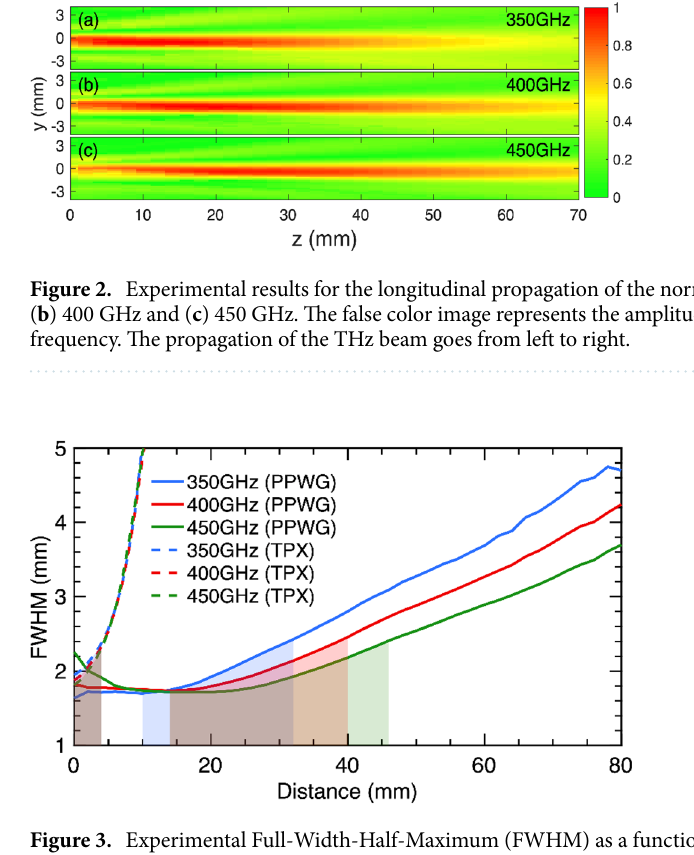
Figure 3. Experimental Full-Width-Half-Maximum (FWHM) as a function of distance and frequency for the TPX lens and the metallic axicon. The shaded regions denote the depth of focus of the two optical elements. These shaded regions star at the minimum of the FWHM curve ( FWHM min ) and end at the point where the FWHM min . From these curves the improved capabilities of the PPWG-based FWHM reaches a value of √ 2 ∗ axicon are